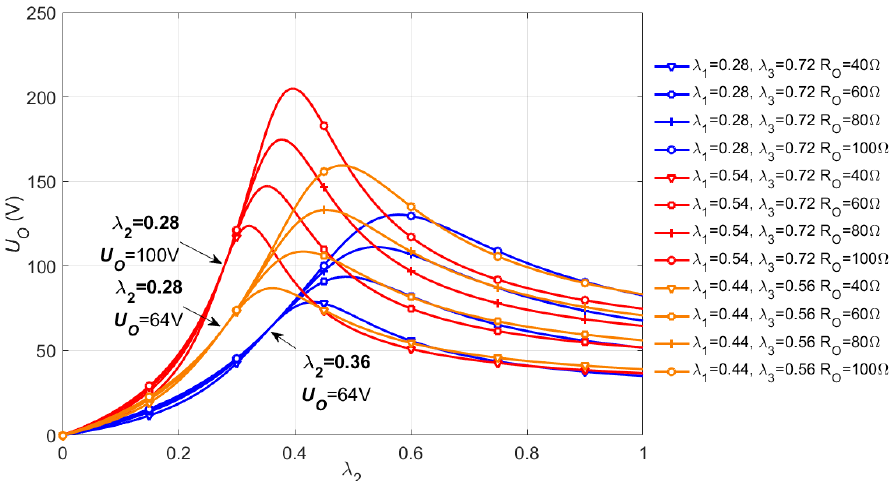
Figure 6. Relationship between of U O and λ 1 , λ 2 .